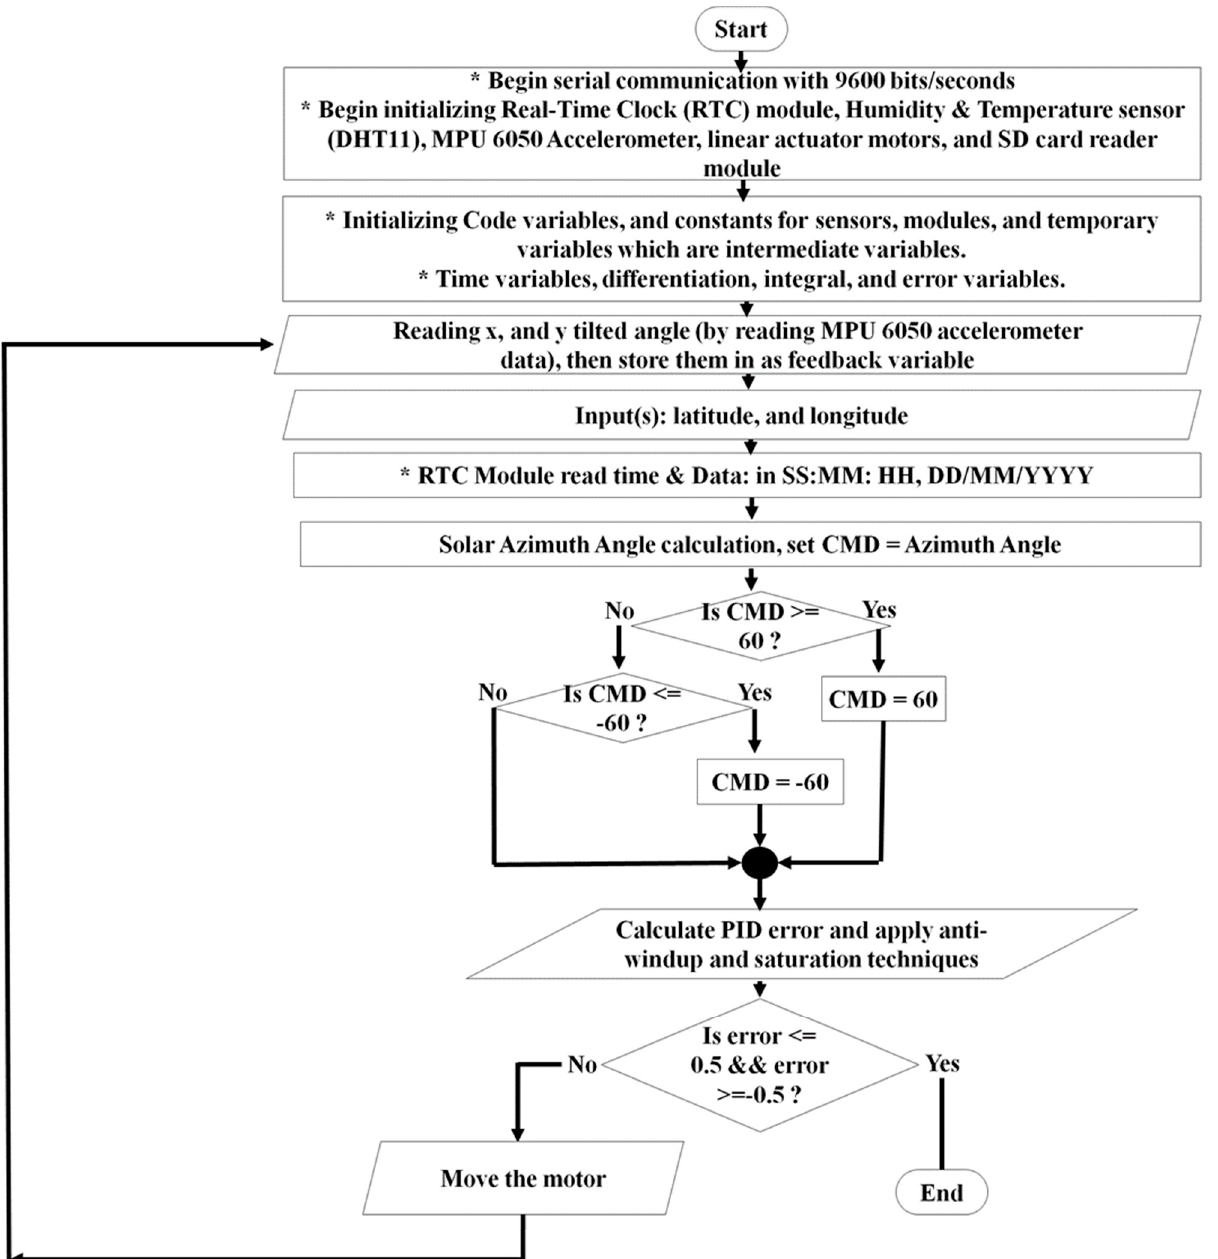
Figure 6. Flow chart algorithm operation for azimuth-based SAST.